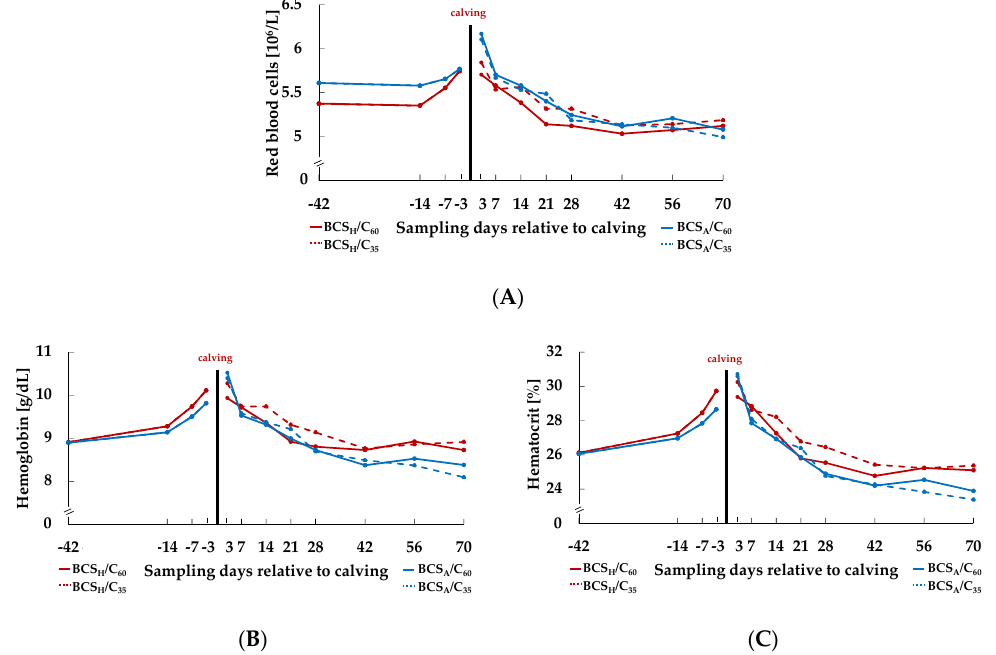
Figure A1. Characteristics of red blood cell counts ( A ) , Hemoglobin ( B ) and Hematocrit ( C ) in the course of the experiment. Ante partum , cows were categorized in high body condition score (BCS, BCS H ) and adequate BCS (BCS A ). Post partum , the two groups were subdivided again, each into a group with a concentrate proportion of 60% (C 60, solid line) in the ration (increasing from 35–60% during the first three weeks after calving) and a group with a concentrate proportion of 35% (C 35 , dashed line) in the ration. Thus, four groups emerged: BCS H /C 60 ( n = 15), BCS H /C 35 (n = 15), BCS A /C 60 ( n = 15), BCS A /C 35 ( n = 15). * before calving: − 42 day, − 14 day, − 7 day, − 3 day; after calving: 3 day, 7 day,